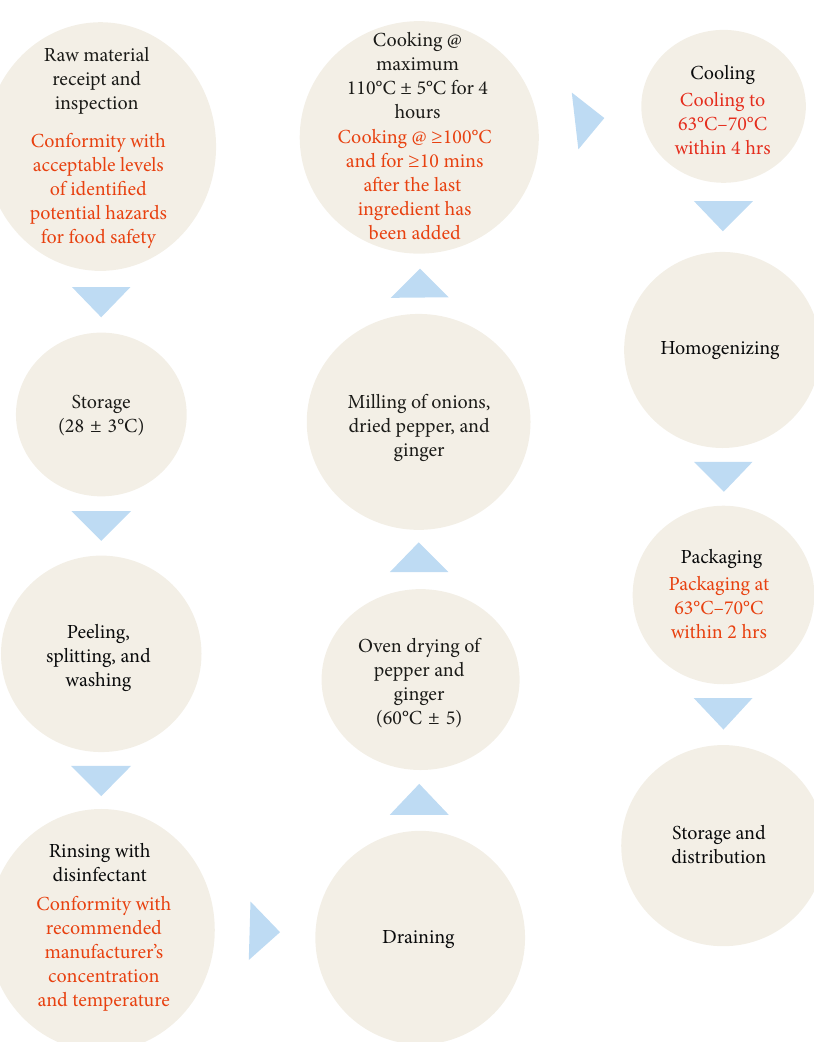
Figure 1: Flow diagram for vegetable shito